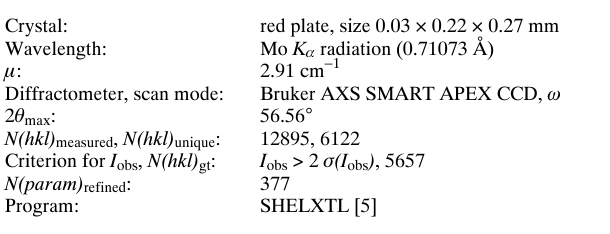
Table 1. D a t a collection a nd h a ndling.